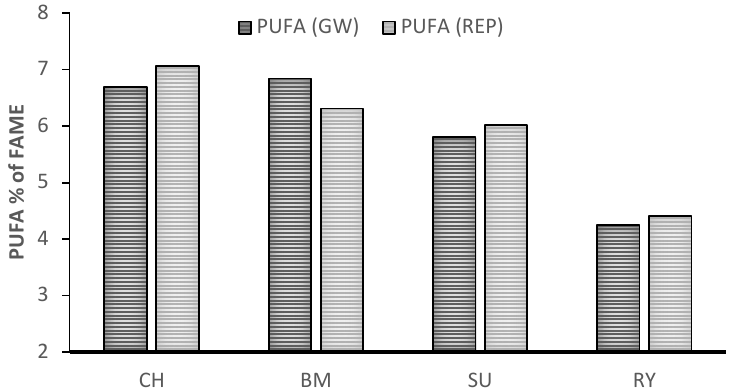
Figure 5. Level of milk polyunsaturated fatty acids (PUFA) of sheep feed with fresh herbage cut at vegetative (GW) and reproductive stage (REP). Annual ryegrass (RY, Lolium rigidum Gaudin), sulla (SU, Hedysarum coronarium L.), burr medic (BM, Medicago polymorpha L.), and a daisy forb (CH, Chrysanthemum coronarium L.) [35].